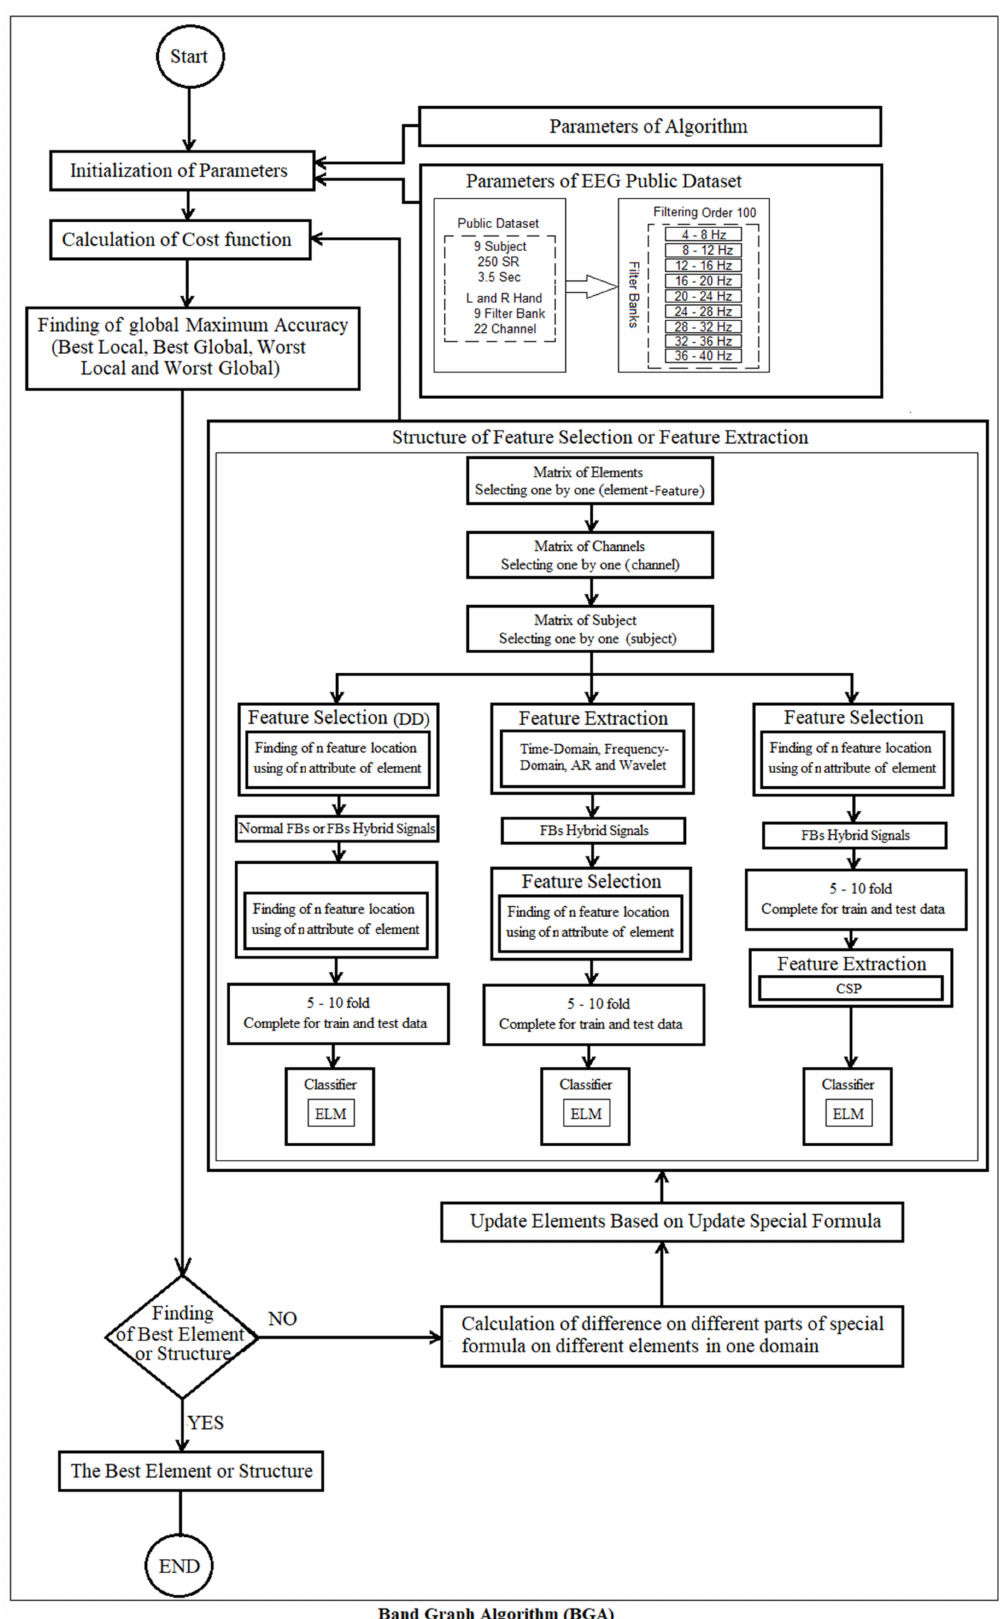
Figure 3. The overview of the dimension reduction using the BGA algorithm and proposed methods for feature selection and feature